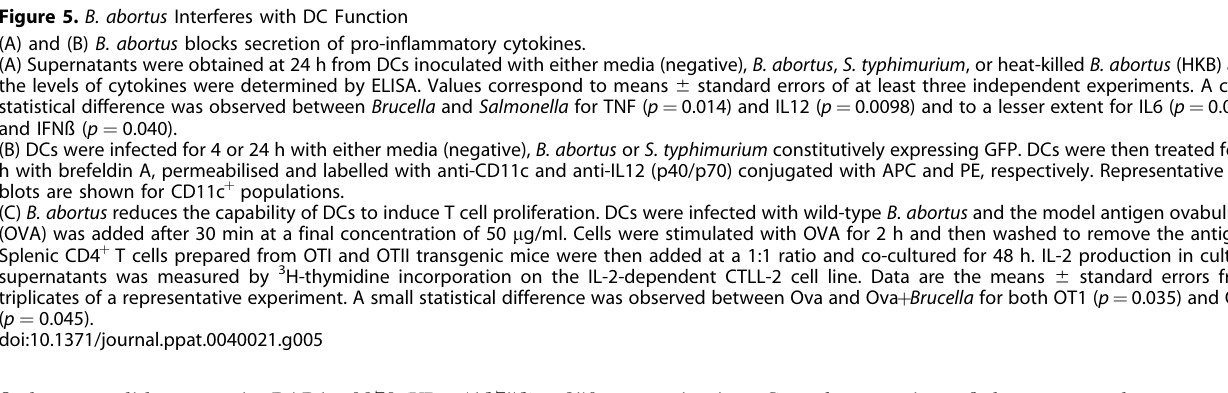
fied one candidate protein: BAB1_0279 (YP_413753), a 250-